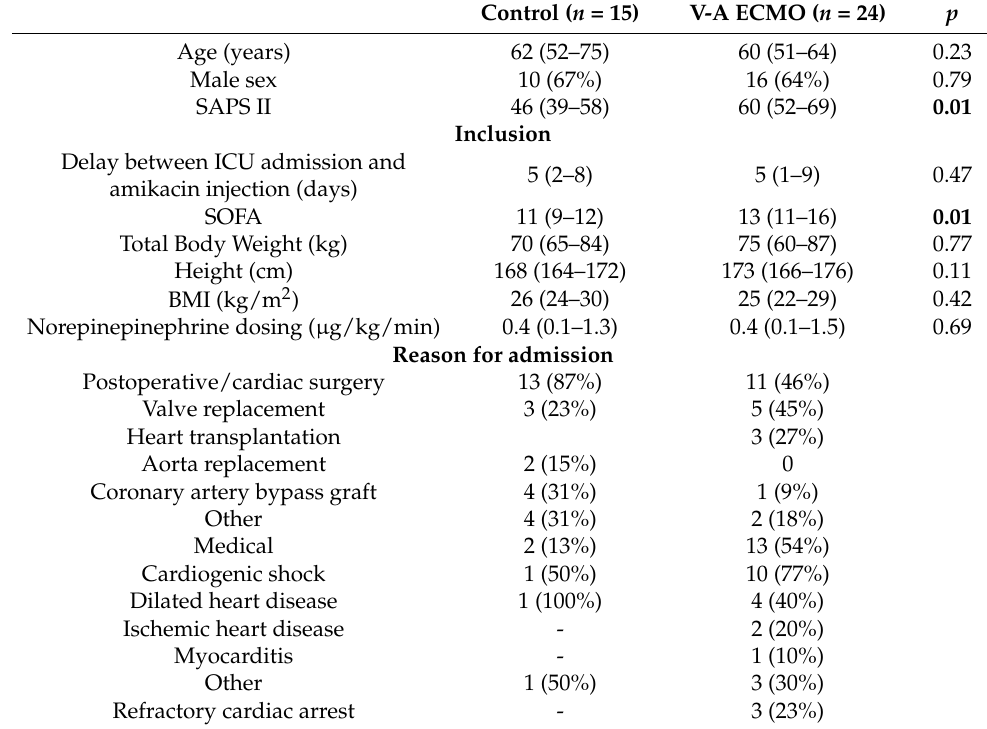
Table 1. Demographic characteristics of the